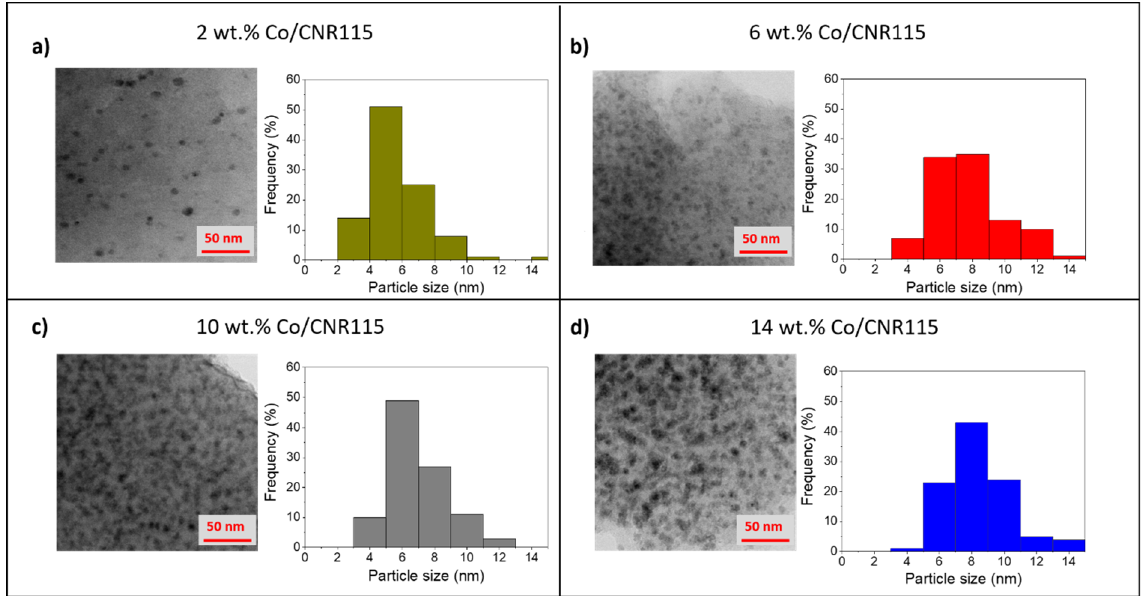
Figure 3. Transmission electron microscopy (TEM) images and Co particle size distribution of ( a ) 2 wt.% Co/CNR115, ( b ) 6 wt.% Co/CNR115, ( c ) 10 wt.% Co/CNR115, and ( d ) 14 wt.% Co/CNR115.